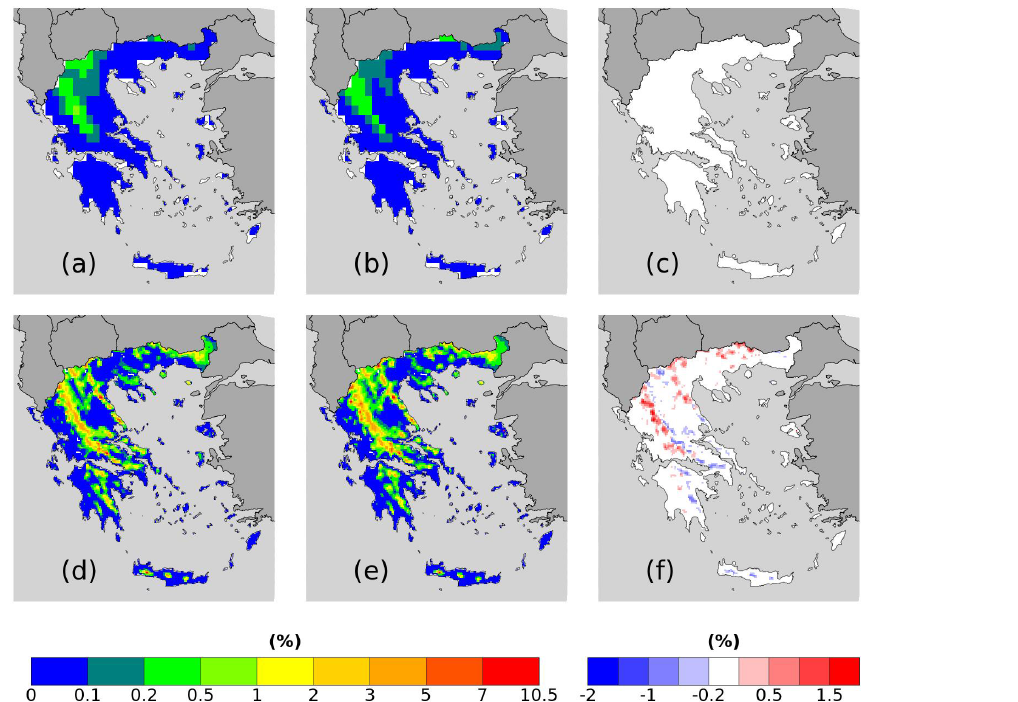
Figure 7. RR20ID probabilities for (a–c) ERA5 and (d–f) WRF_ERA_I produced by (a, d) empirical and (b, e) copula a (c) = (b) – (a) and (f) = (e) – (d)